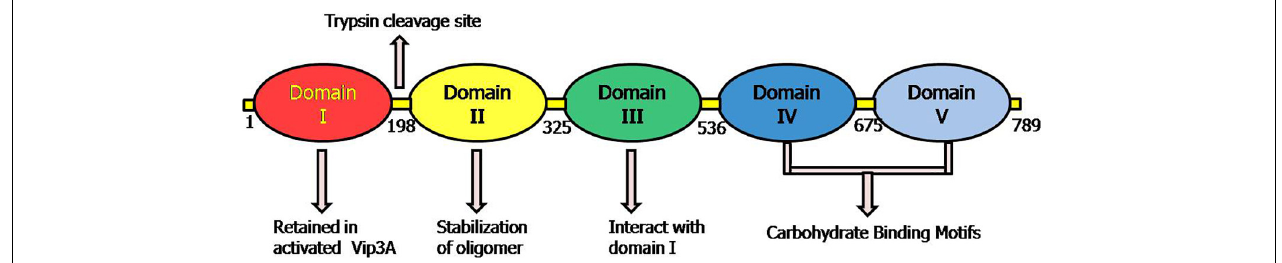
FIGURE 4 | Representative picture of domains and their proposed role according to the 3D structure of Vip3 proteins as proposed by Núñez-Ramírez et al. (2020). The positions 1–789 depict the amino acid residues in Vip3A